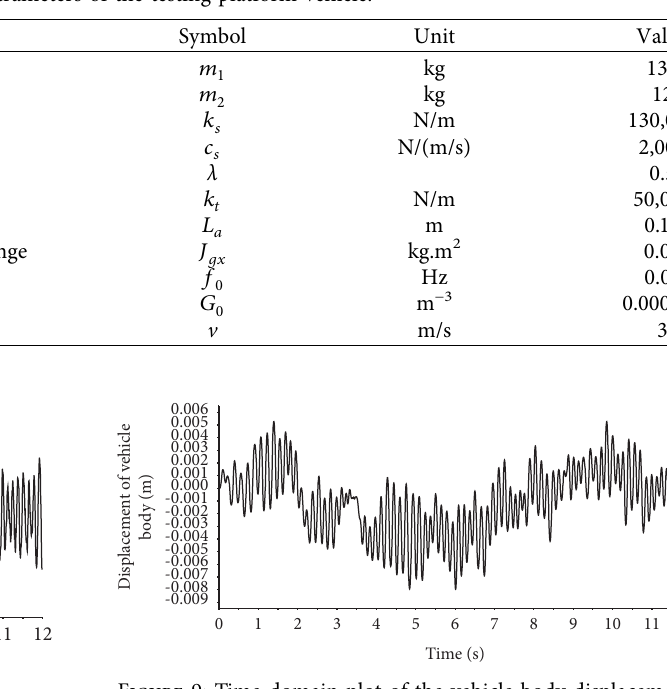
Table 2: Structural parameters of the testing platform vehicle.